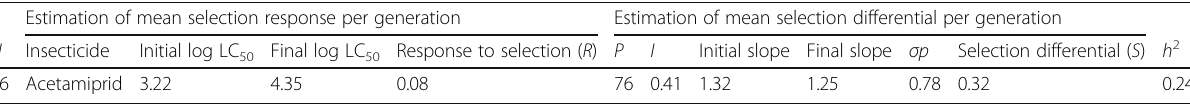
Table 5 Estimation of the realized heritability of resistance to acetamiprid in Aceta-SEL strain of Chrysoperla carnea . Estimation of mean selection response per